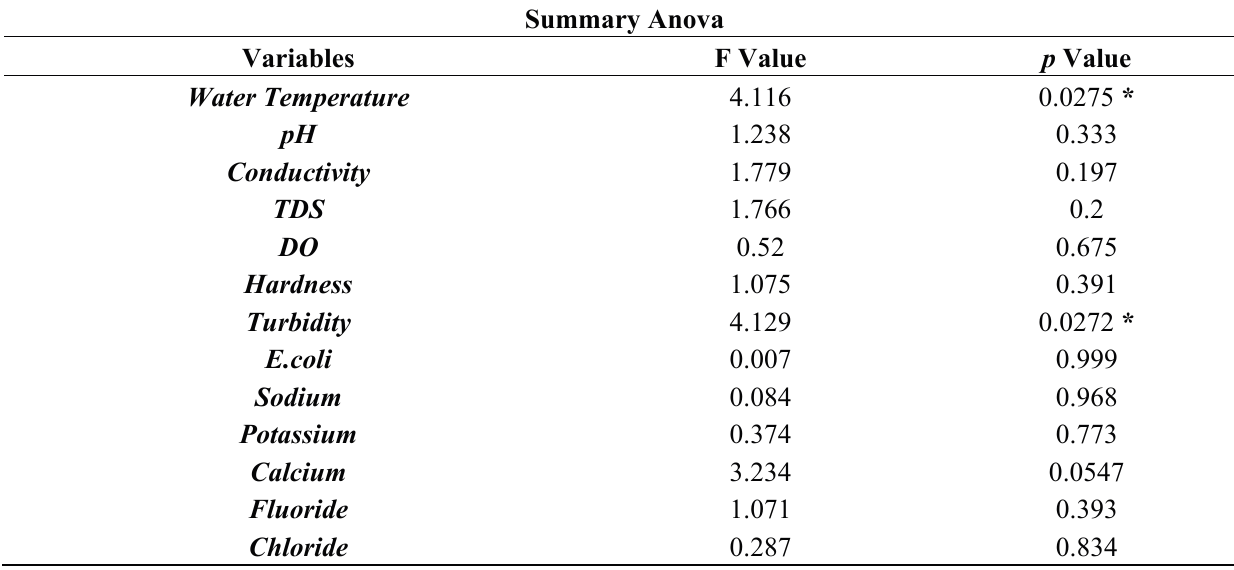
Table 5. Analysis of variance of means for variables between sampling periods (May, June, August and October).